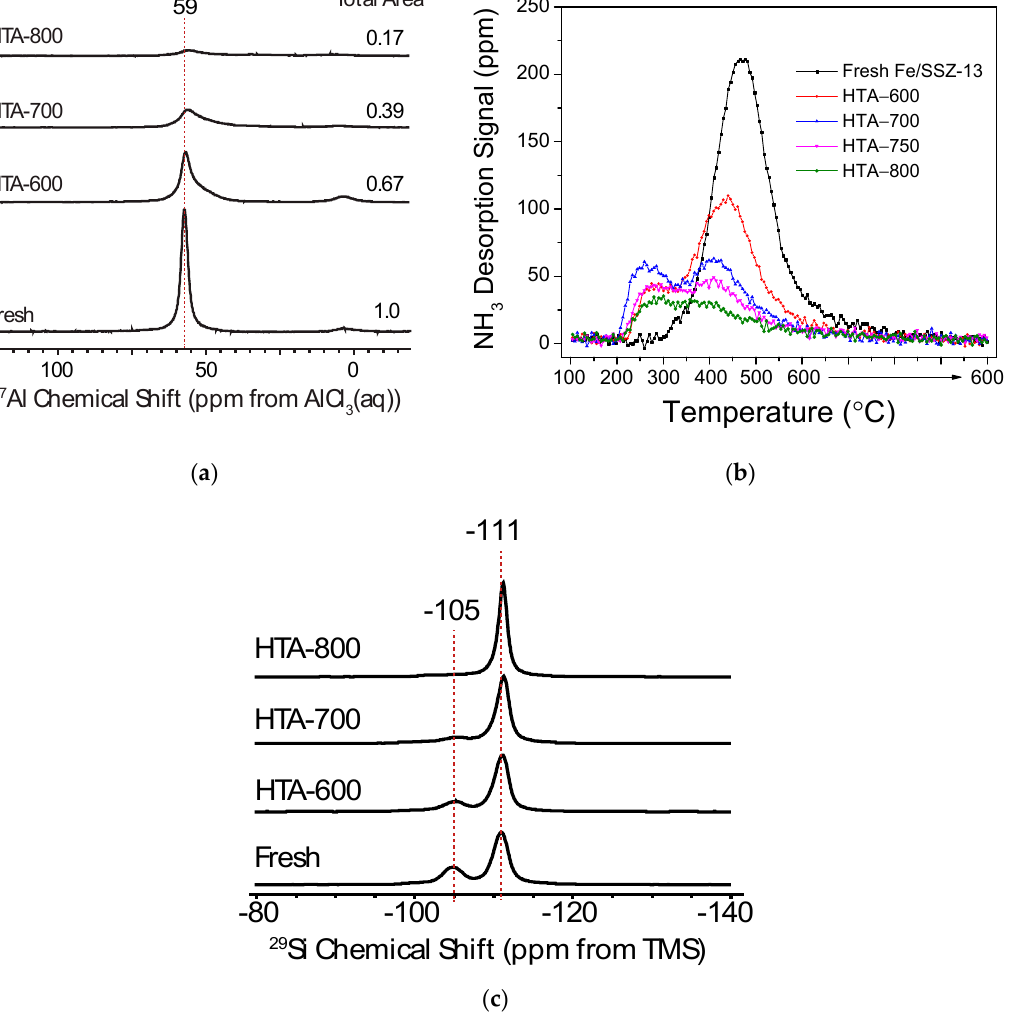
Figure 12. ( a ) Solid-state 27 Al-NMR spectra for the fresh and hydrothermally aged (HTA) Fe/SSZ-13 samples (Si/Al = 12, Fe loading 1.20 wt%). Tetrahedral Al contents for the HTA samples were normalized against the fresh sample, and the values are marked adjacent to each spectrum. ( b ) NH 3 -TPD for the fresh and HTA. NH 3 is adsorbed at 100 °C. Ramping rate = 10 °C/min. ( c ) The corresponding 29 Si-NMR spectra showing gradual conversion of Si(OSi) 3 (OAl) to Si(OSi) 4 with increasing aging temperature. ( a , c ) reprinted with permission from [32]. Copyright © 2017 American Chemical Society; ( b ) reprinted with permission from [31]. Copyright © 2016 Springer Science+Business Media New York.